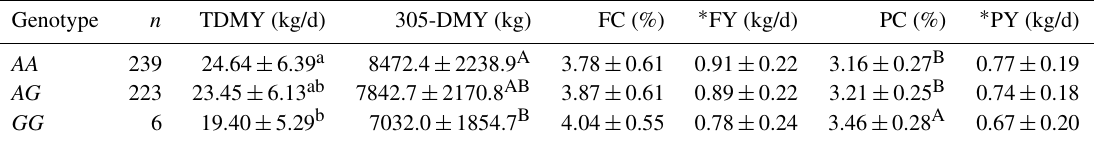
Table 3. Comparison results for the milk-related traits examined in Holstein cattle based on GHR / AluI genotypes (mean ± SD). Genotype n TDMY (kg/d)